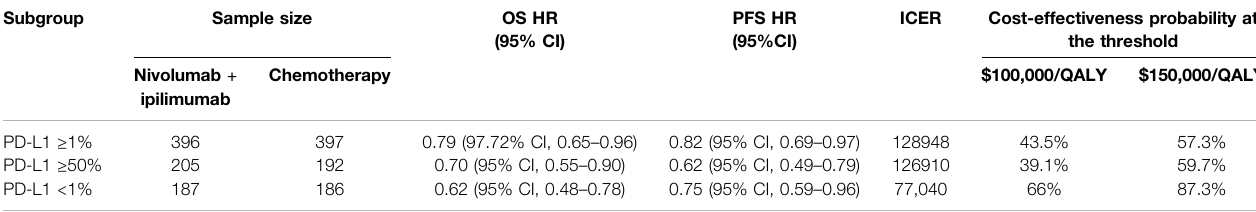
TABLE 2 | Results for subgroup analyses.